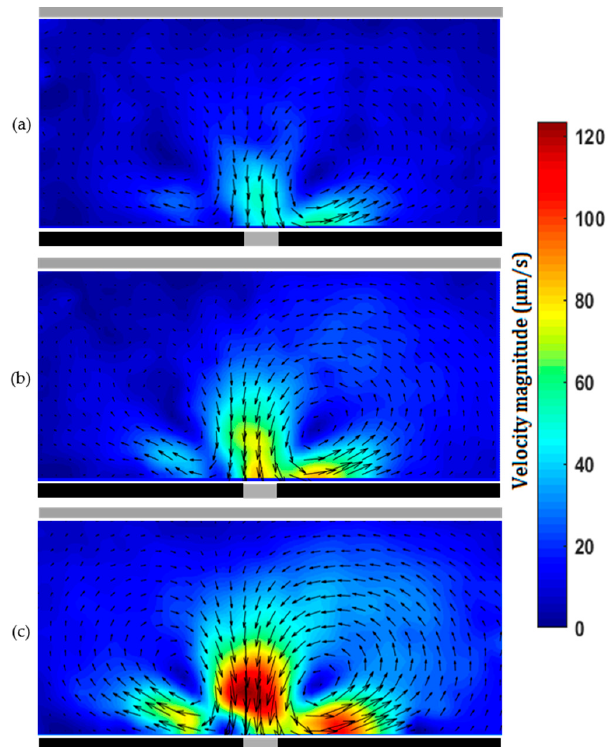
Figure 4. Alternating current electroosmosis (ACEO ) flow of 1 mM KCl solution between two parallel 0.3 mm pencil-lead electrodes with a gap of 40 µm in a microchannel of 0.3 mm diameter. AC voltage of ( a ) 30 V p-p ; ( b ) 35 V p-p ; ( c ) 40 V p-p with a frequency of 50 kHz.